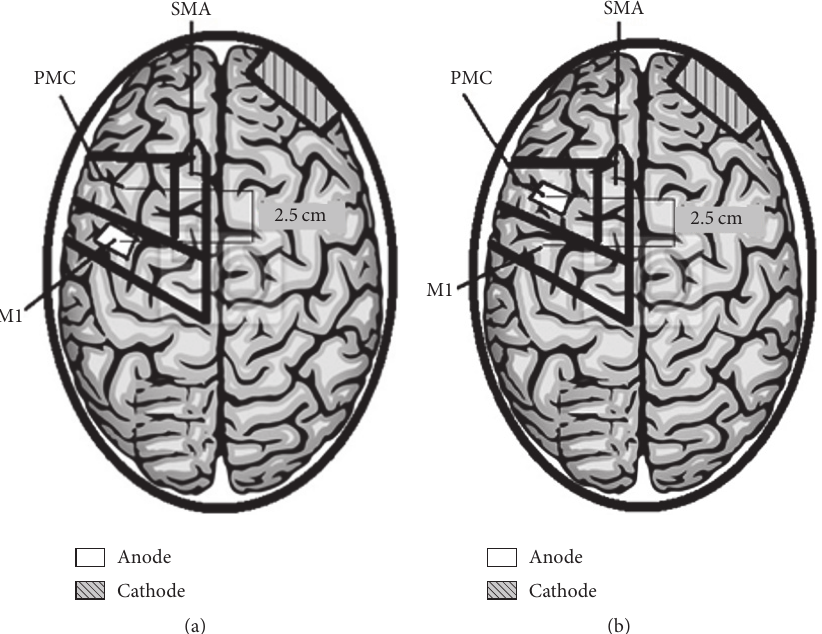
Figure 2: Electrode montage of 10 tDCS sessions. (a) M1 group. (b) PMC group. SMA: Supplementary Motor Area. Figure adapted from Pavlova et al. [2].